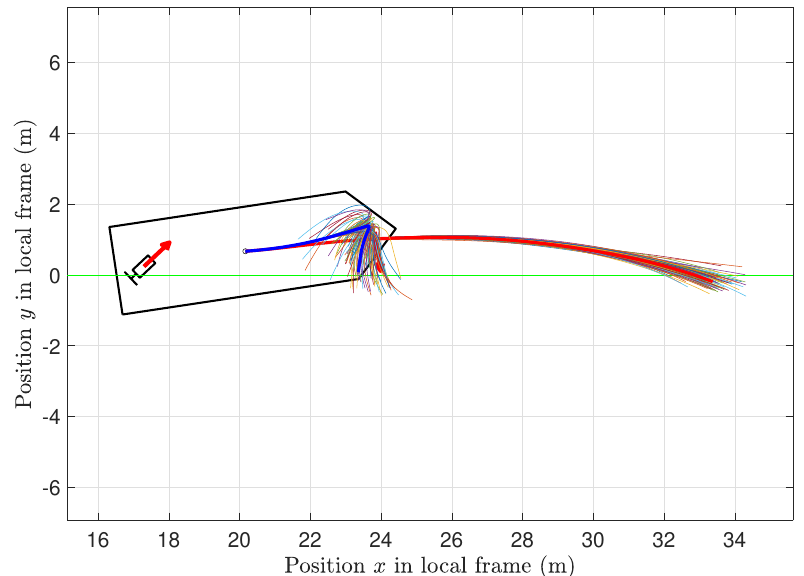
Figure 1. Explored state–space in a full–scale experiment visualized by sampled trajectories using proposal densities with mean U 0 (red) and mean U F (blue) representing the emergency braking feature. The actuators’ force vectors are drawn in red. The desired trajectory is visualized in